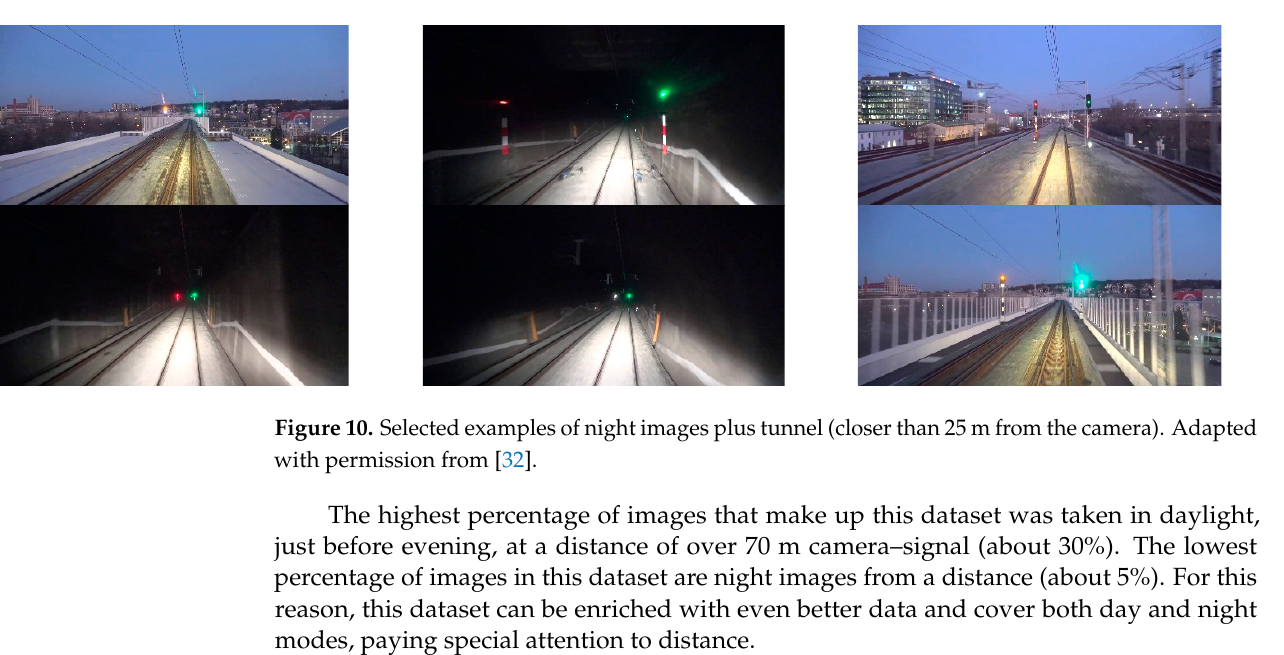
Figure 9. Selected examples of daily images—morning (more than 75 m from the cameraSdapted with permission from [32].